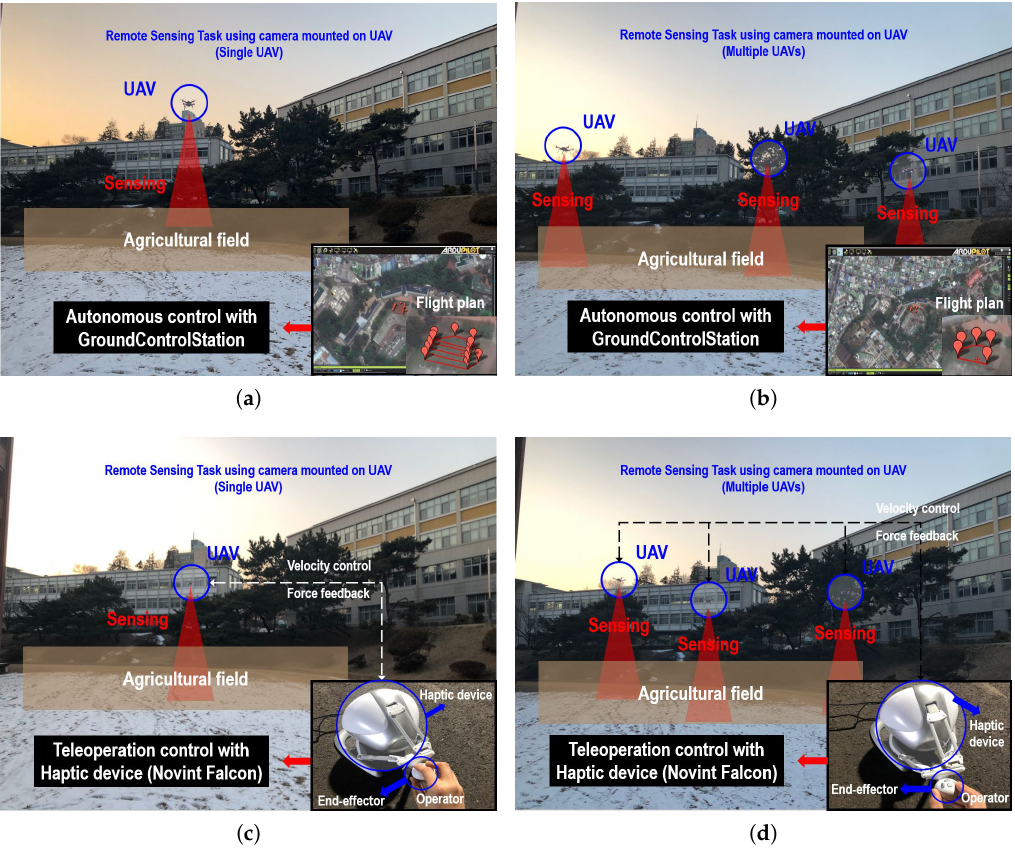
Figure 2. Experimental setup for experiments: Unmanned aerial vehicle (UAV) performs remote sensing task in the test area ( a ) case of Auto-Single-UAV ( b ) case of Auto-Multi-UAV ( c ) case of Tele-Single-UAV ( d ) case of Tele-Multi-UAV .